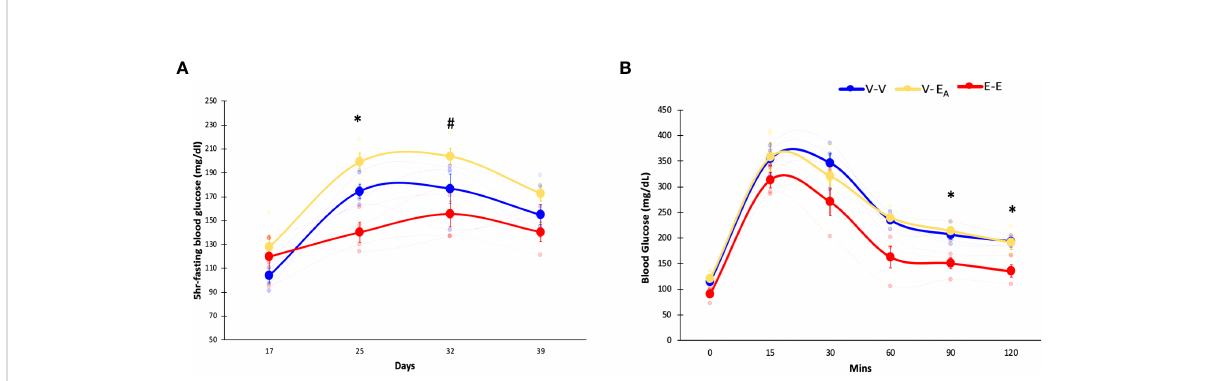
FIGURE 3 Estradiol treatment protected, while A . muciniphila -supplemented fecal microbiota transplant (FMT) from E2-treated lean mice exacerbated, HFD-induced hyperglycemia in female mice. (A) Blood glucose levels during HFD feeding, (B) Glucose tolerance test (GTT) measured on D45. *denotes differences across E-E, V-E A , and V-V. # denotes differences between E-E and V-E A (*, # p < 0.05, t-test). E-E, E2-treated mice receiving FMT from E2 mice (n = 4); V-V, mice with Veh implants receiving FMT from Veh mice (n = 4); V-E A , mice with Veh implants receiving FMT from E2-treated mice supplemented with A . muciniphila (n =